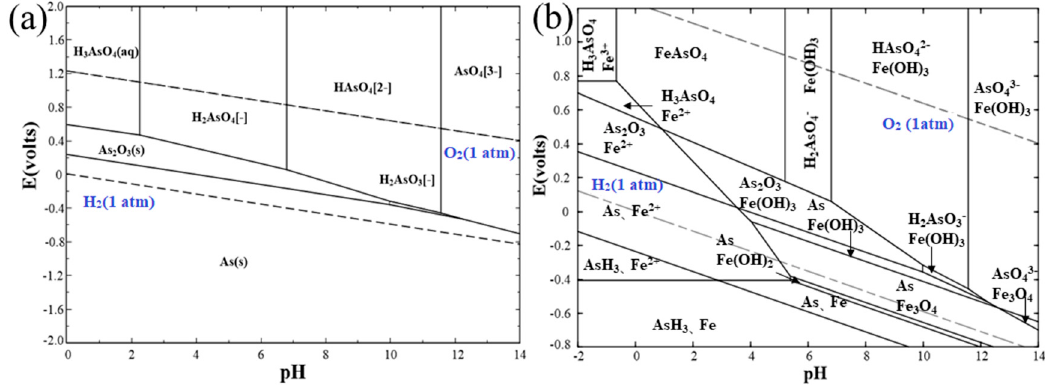
◦ C. ( a ) As–H 2 O systems ( b ) As–Fe–H 2 O